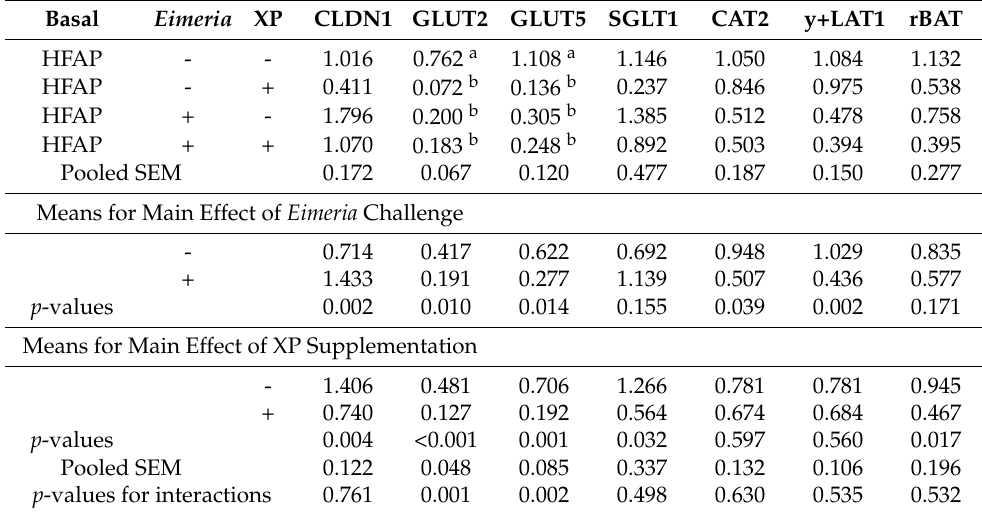
p -values for interactions